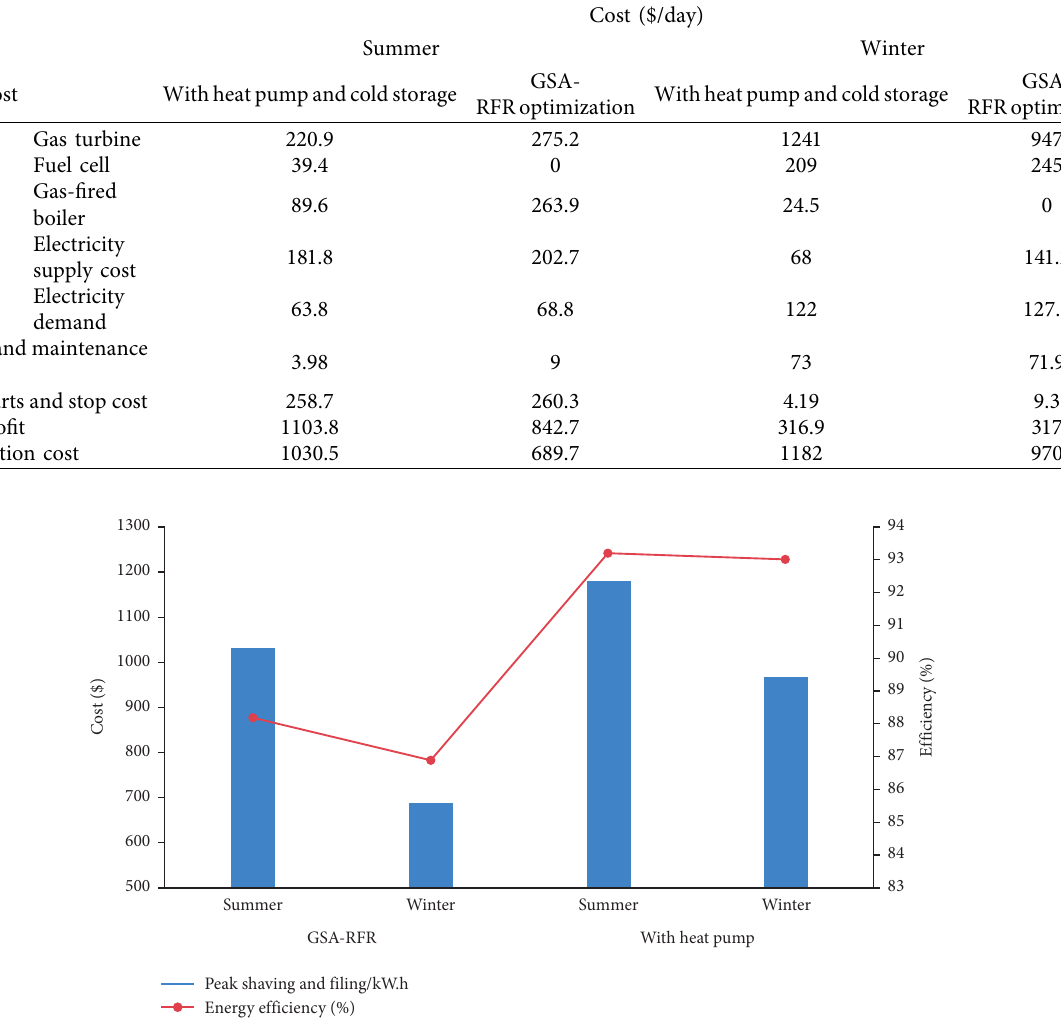
Figure 9: A final comparison of GSA-RFR and with heat